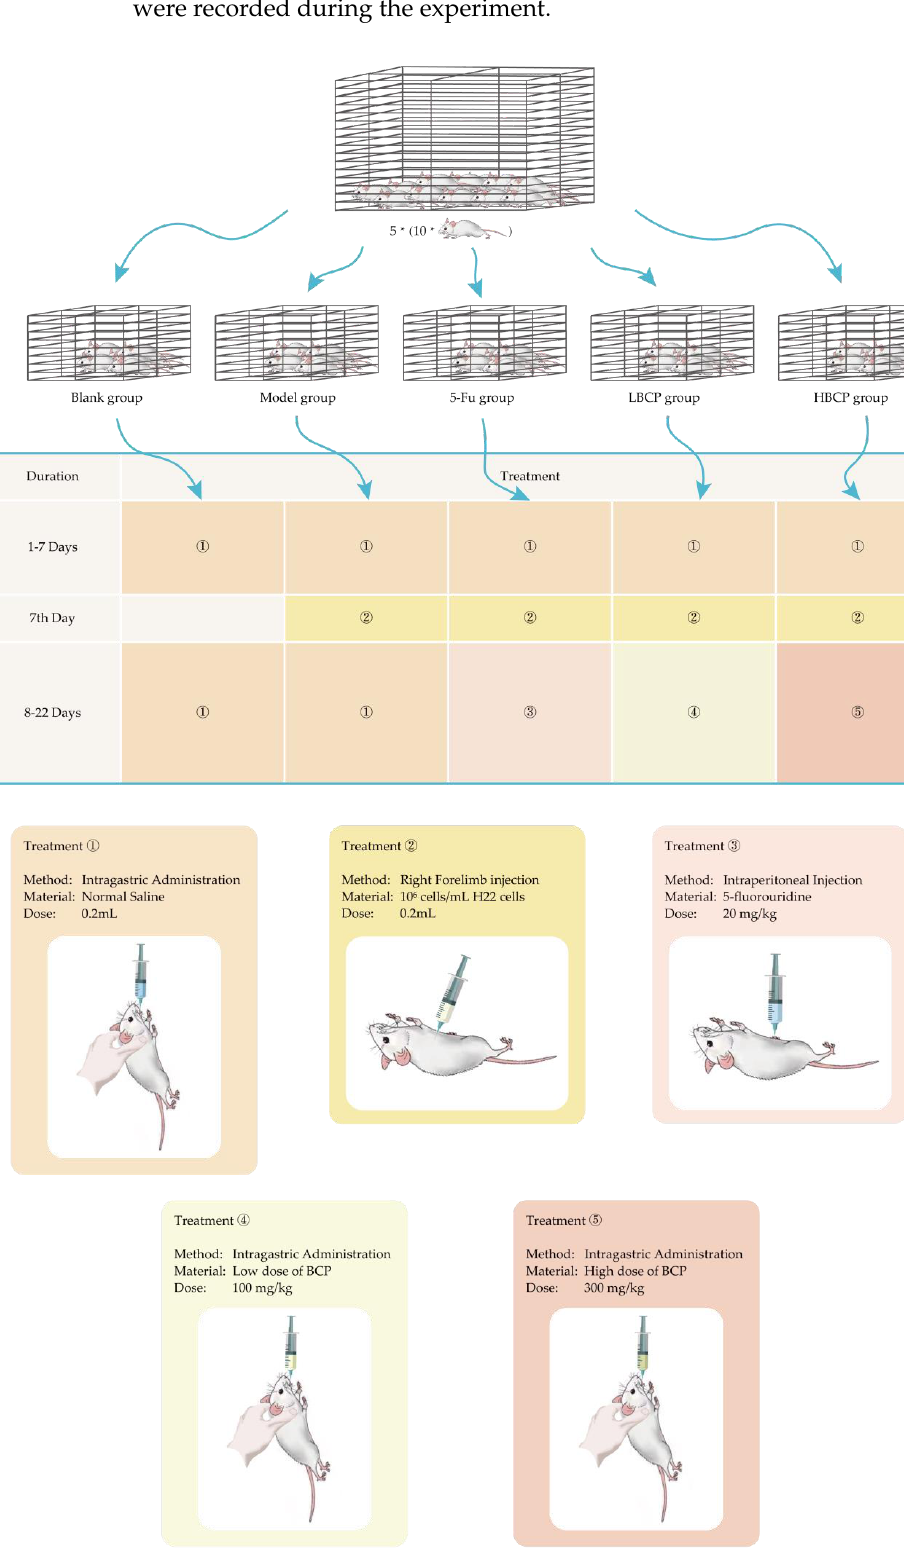
Figure 2. The establishment of H22 tumor-bearing mouse model process.